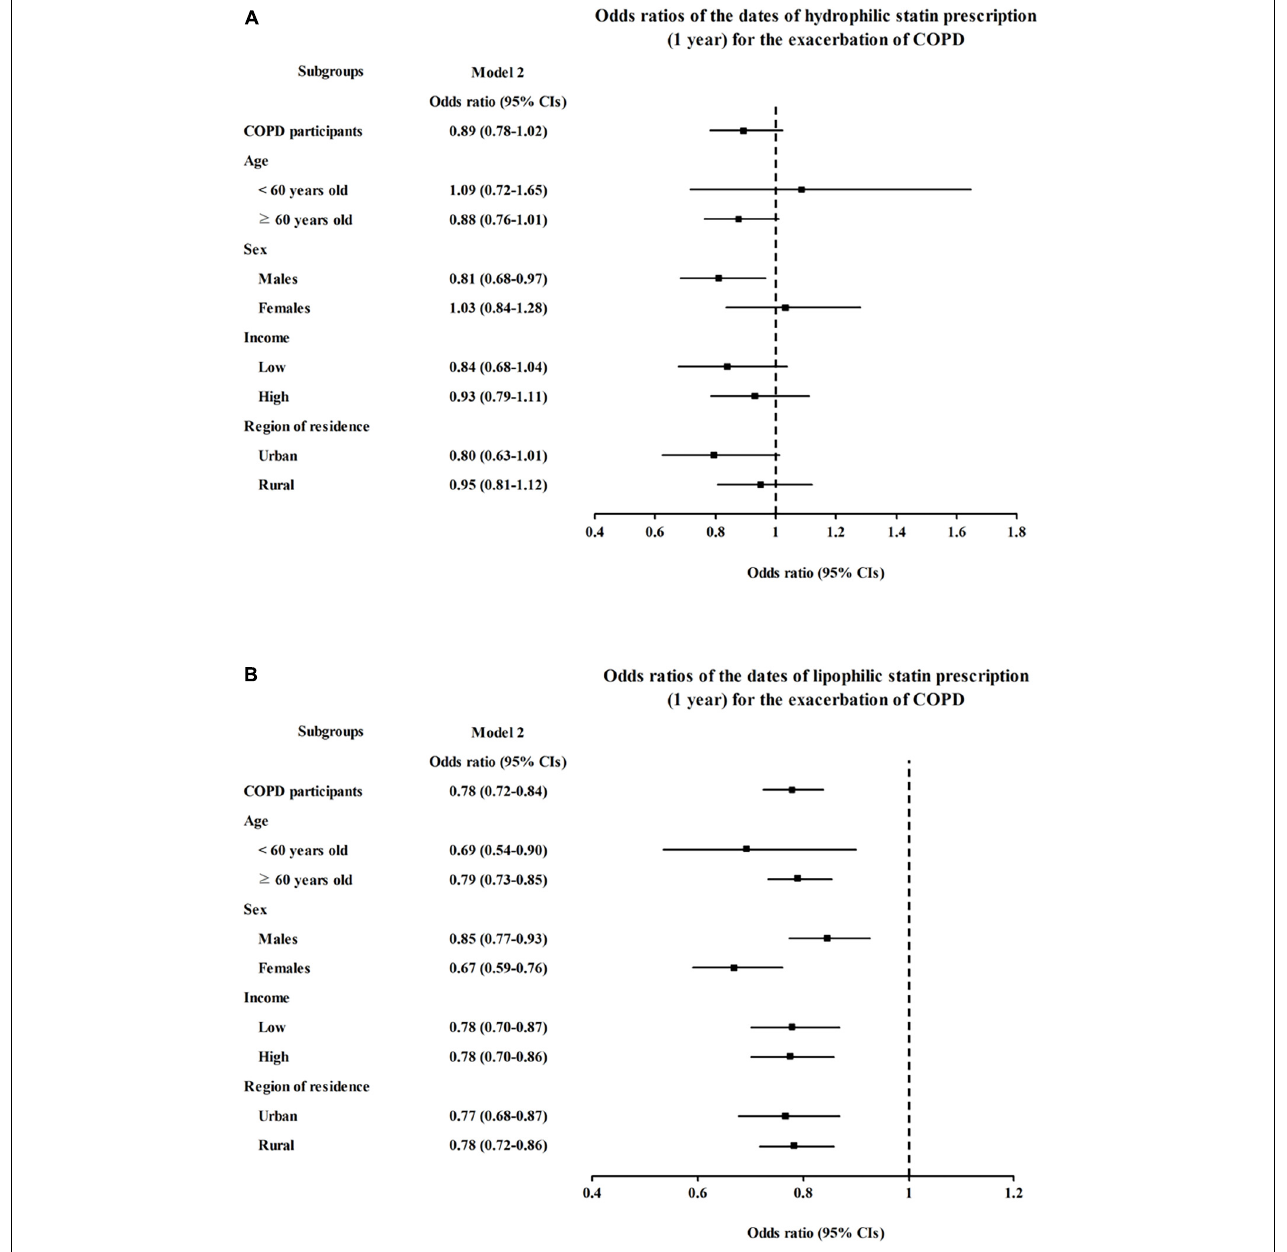
FIGURE 3 | Adjusted odds ratios (95% CIs) of statin prescriptions per 1 year for COPD exacerbation by subgroup: (A) hydrophilic statins and (B) lipophilic statins. Model 2 was adjusted for age, sex, region of residence, total cholesterol, SBP, DBP, fasting blood glucose, obesity, smoking, alcohol consumption, history of dyslipidemia, history of asthma, and CCI scores. CI, confidence interval; CCI, Charlson comorbidity index; COPD, chronic obstructive pulmonary disease; DBP, diastolic blood pressure; SBP, systolic blood pressure.